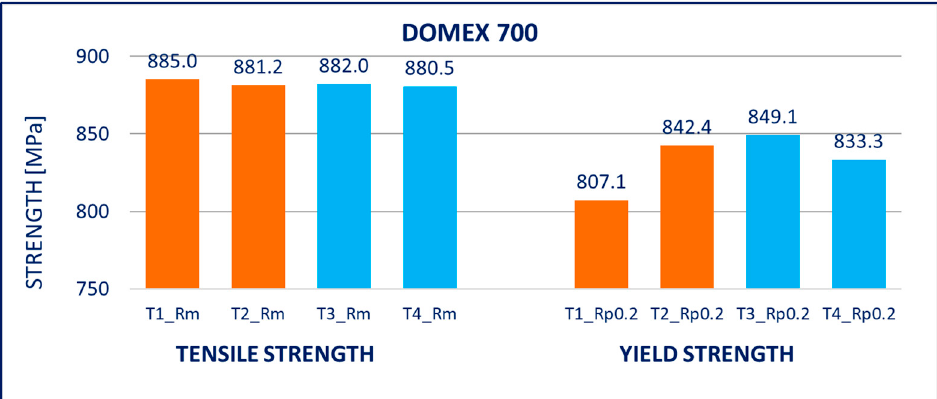
Figure 7. Tensile tests of specimens from DOMEX 700 steel. Description of specimens: T1 and T2 are groups of specimens without zinc coating; T3 and T4 are groups of specimens after hot-dip galvanization. R m is tensile strength, R p 0.2 is yield strength.